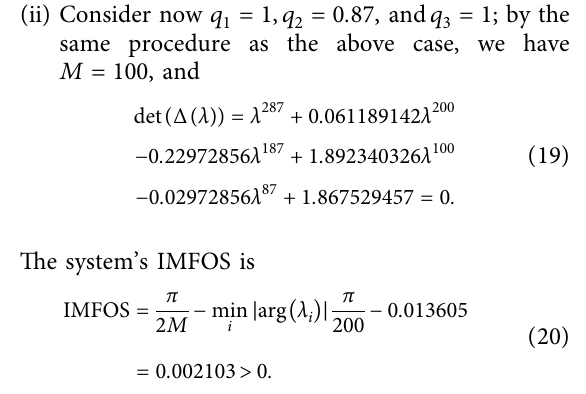
Figure 5: Phase diagrams of system (6) with fractional orders q x − z phase